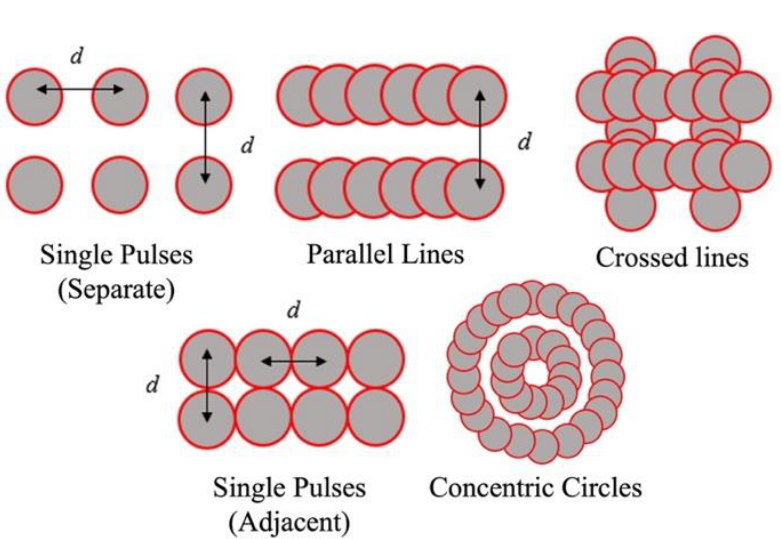
Figure 2. Schematic representation of scanning strategies employed for laser texturing experiments (see Table 1). Table 1. Summary of laser processing parameters employed for experiments.